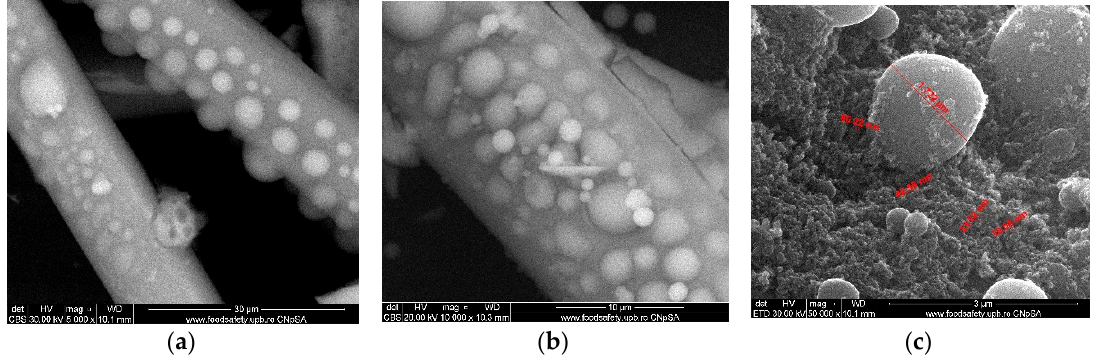
Figure 4. Titanium dioxide grafted silica microfiber after surface activation: Silica microfiber with titanium dioxide ( a , b ); detail to highlight the dimensions ( c ).